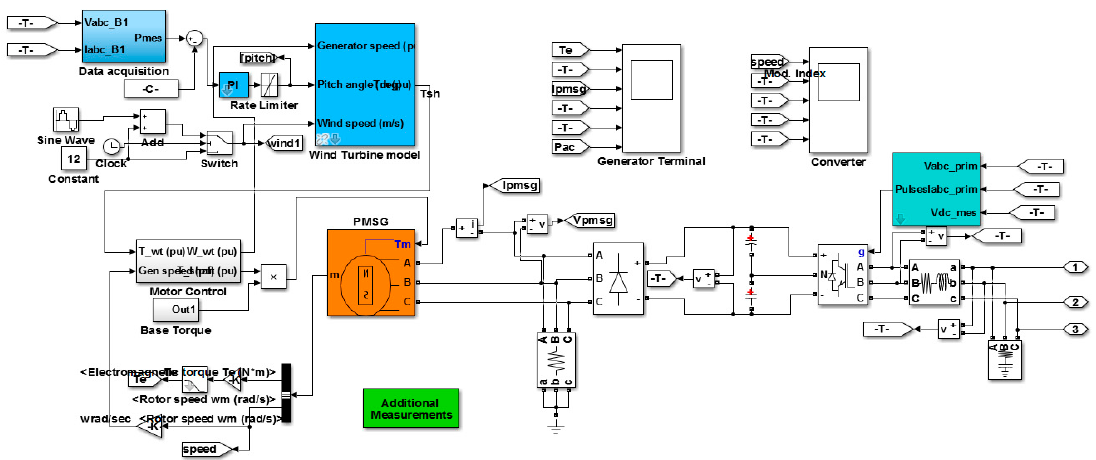
Figure 5. Simulink model of the wind turbine.